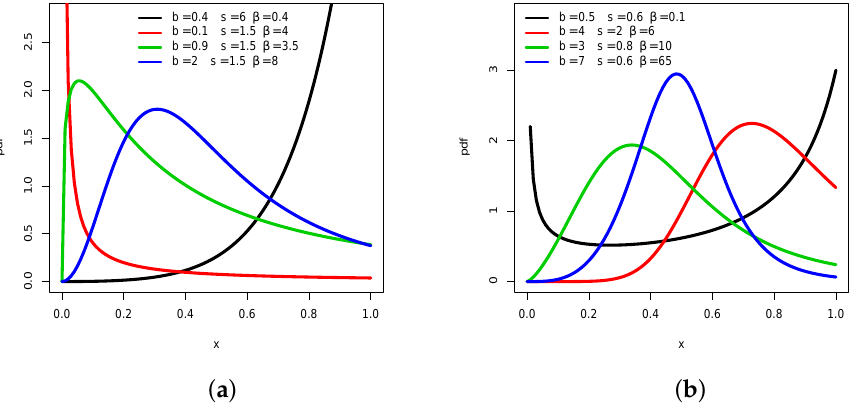
Figure 1. Plots of f UG / G ( x ; b , s , β ) for several values of b , s and β showing ( a ) decreasing, increasing, and “increasing-decreasing” highly right-skewed shapes, and ( b ) “increasing-decreasing” moderately right-skewed or almost symmetric and “decreasing-increasing”